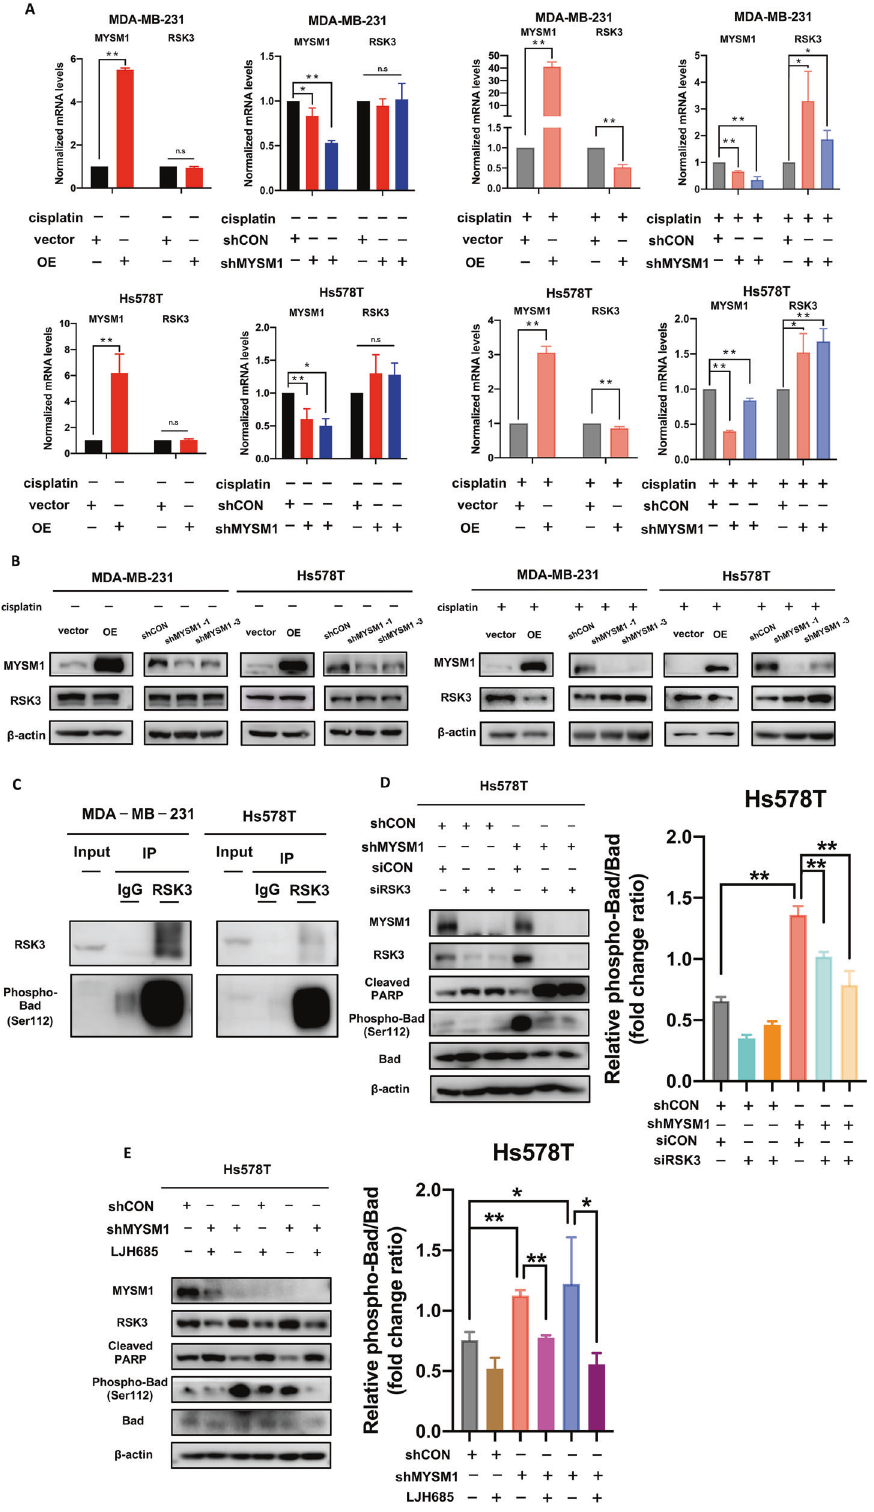
Similar results were observed in LJH685-treated cells (Fig. 5D – F). After being pretreated with LJH685 (50 µM) for 24 h, the shMYSM1 cells showed higher levels of apoptosis (Fig. 5D), ROS production (Fig. 5E), and lower cell viabilities (Fig. 5F) than the vehicle-treated shMYSM1 cells. This result offered strong